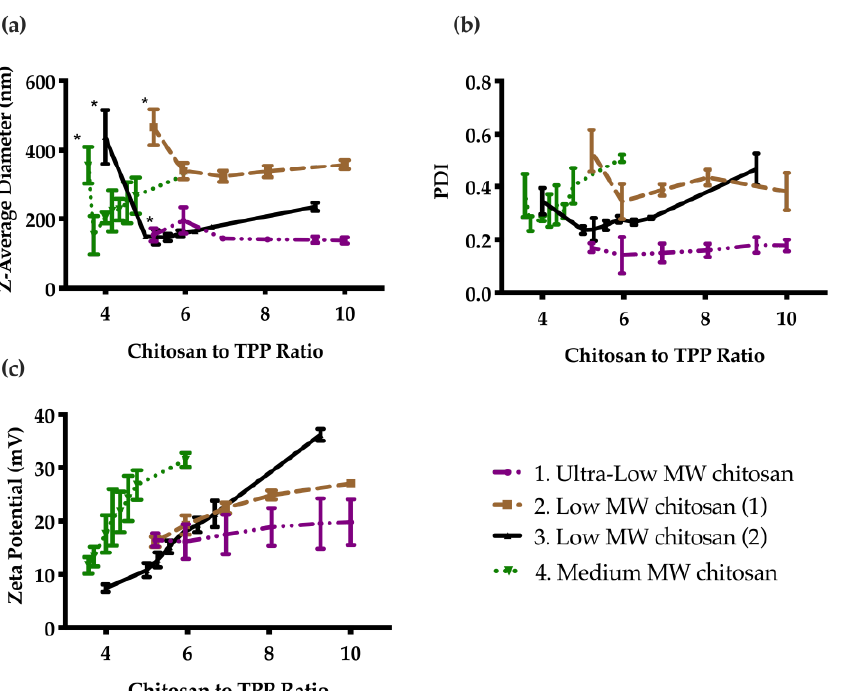
Figure 1. Effect of chitosan to TPP mass ratio on particle properties as measured by DLS: ( a ) Z- average diameter; ( b ) PDI; and ( c ) Zeta potential. Error bars correspond to the standard deviations